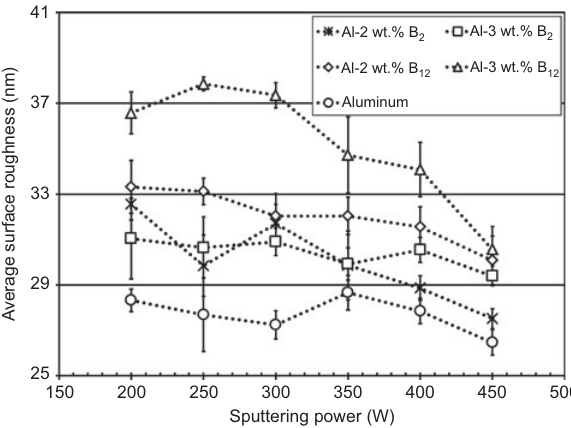
Figure 6 Effect of the underlying substrate on the fi lm ’ s surface roughness.